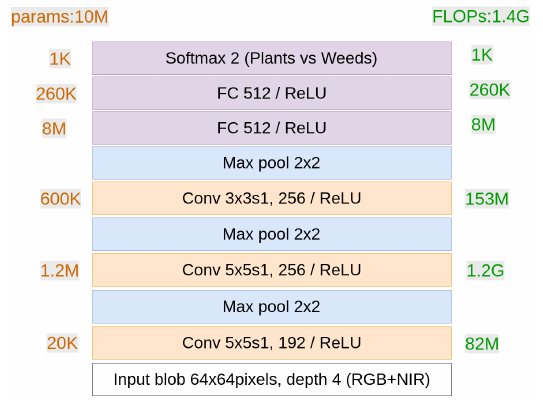
Figure 5. Architecture used for the blob-wise classification, with the size of each layer specified and the amount of floating operations needed per pass.